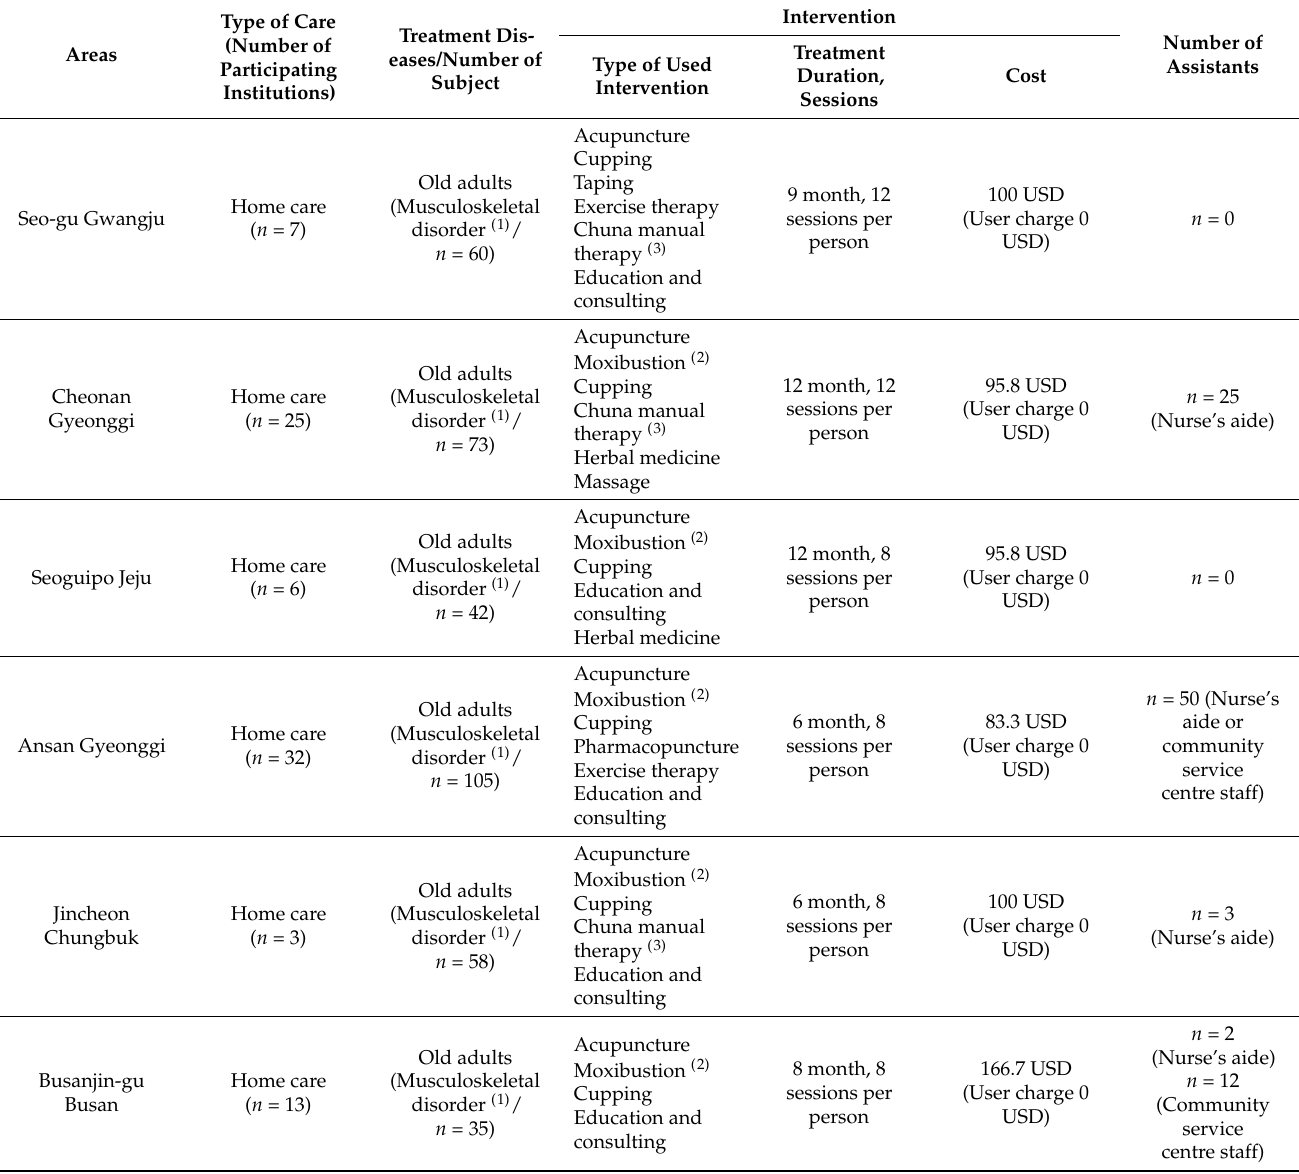
Table 2. Current Provision of TKM Home Care